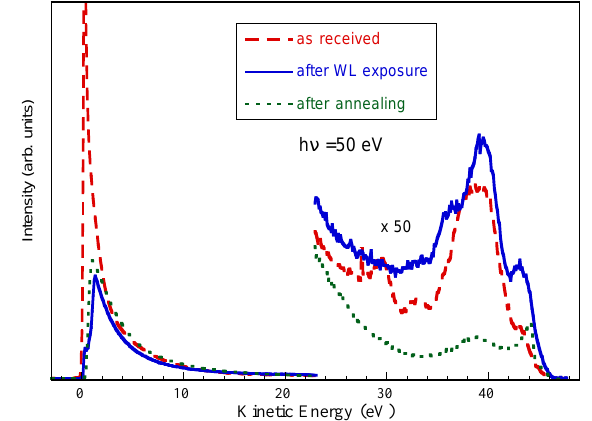
FIG. 6. (Color) The photoemission spectra, taken at 50 eV photon energy, of Cu-el. as received, after WL exposure, and after annealing in UHV (pressure during annealing was less than 5 3 10 2 9 mbar) at (cid:2) 300 6 50 (cid:3) ± C for 2.25 h (Cu-el.-an.).